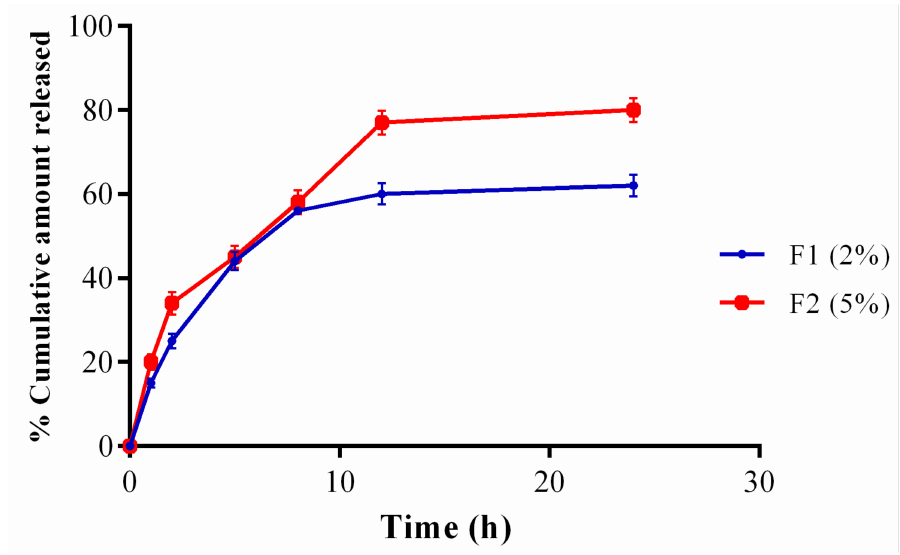
Figure 5. In-vitro permeation study of PPEE cream 2% and 5% Cumulative amount of PPEE released from PPEE-SLNs cream (2% and 5%) is expressed as mean ± S.D.